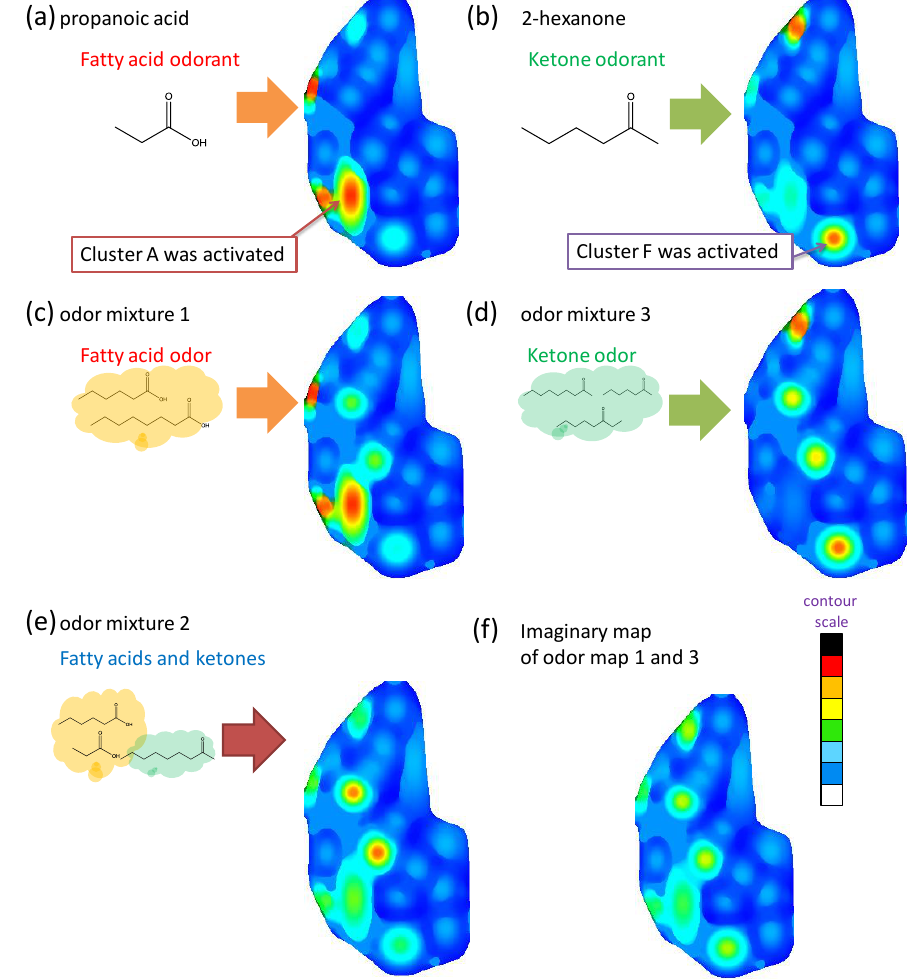
Figure 11. The artificial odor maps of ( a ) propanoic acid, ( b ) 2-hexanone, ( c ) odor mixture 1 (fatty acids), ( d ) odor mixture 3 (ketones), and ( e ) odor mixture 2 (fatty acids and ketones) based on sensor response shown in Figures 9 and 10. The map ( f ) indicates the imaginary odor map obtained by overlaying images of (a) and